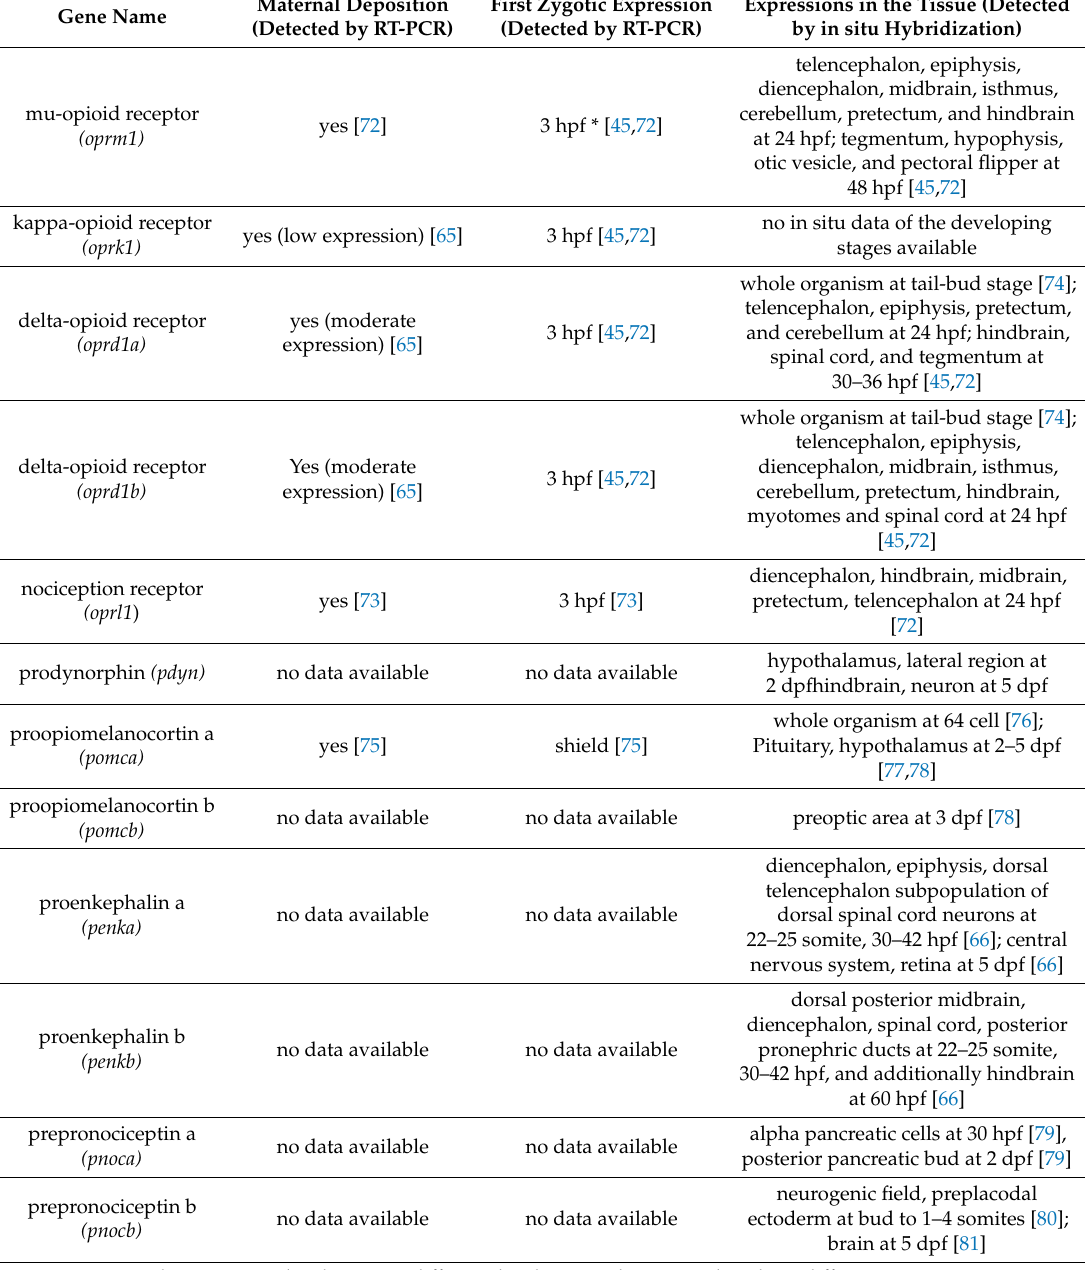
Table 2. Expression patterns of the zebrafish opioid signaling